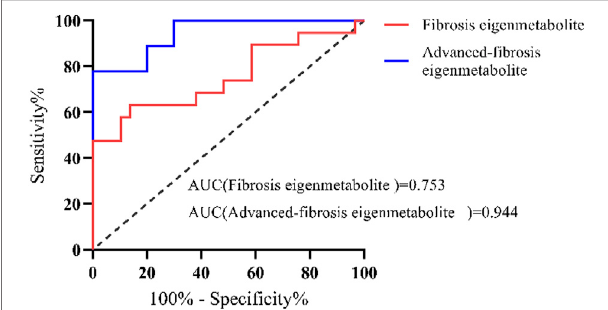
FIGURE 5 | Validation of metabolite fi ngerprints ROC curves of the metabolite fi ngerprint (eigenmetabolite) associated with fi brosis and associated with advanced fi brosis in the validation group of DILI patients.